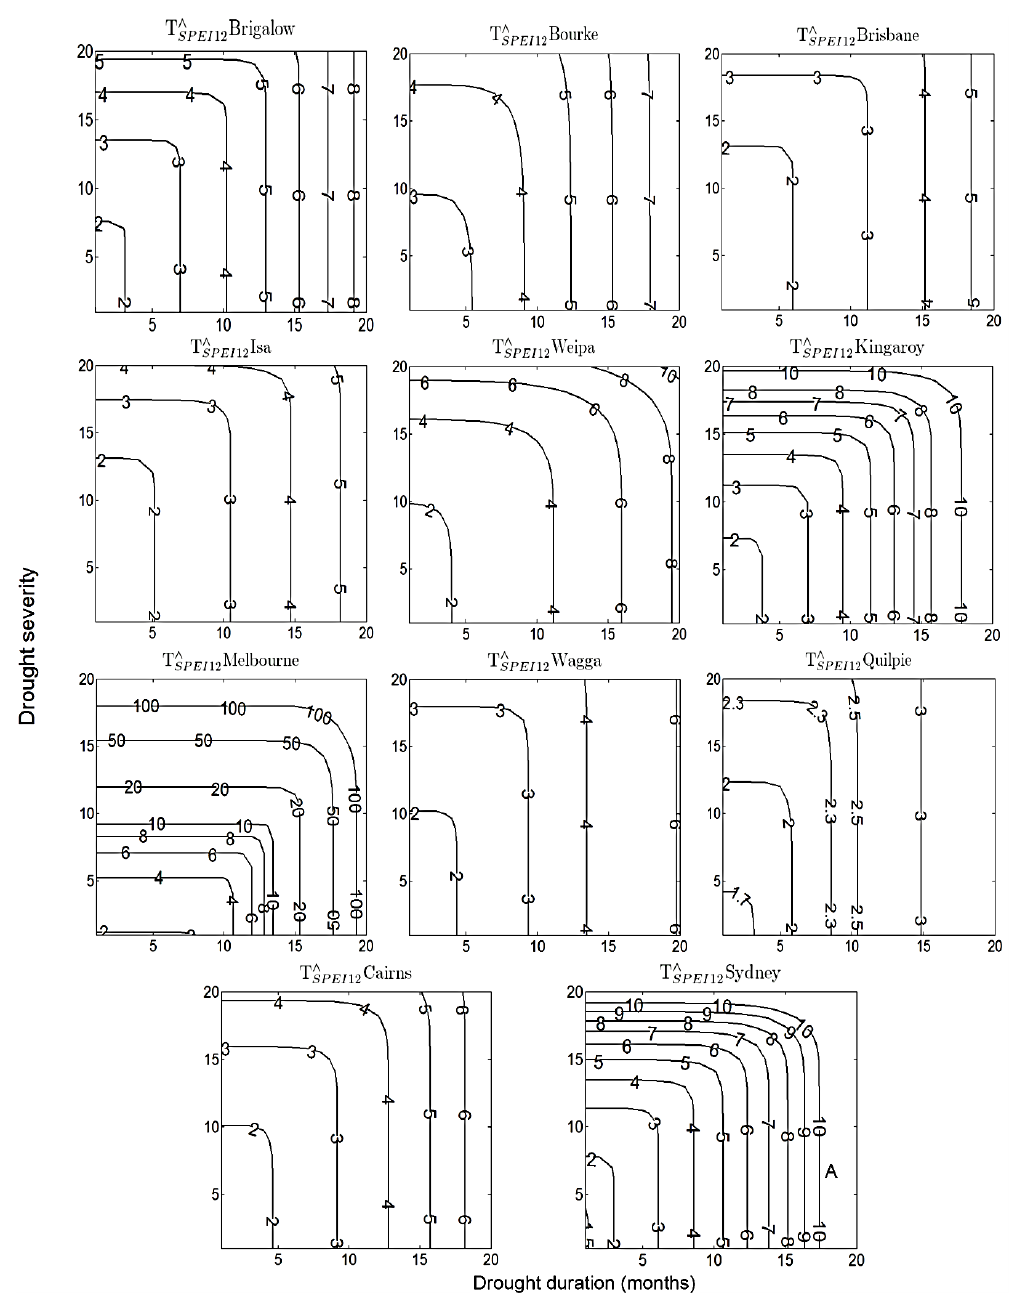
Figure D2. Recurrence intervals T ∧ (years) of drought events with any severity and duration of interest based on SPEI 12 (long-term) of historical